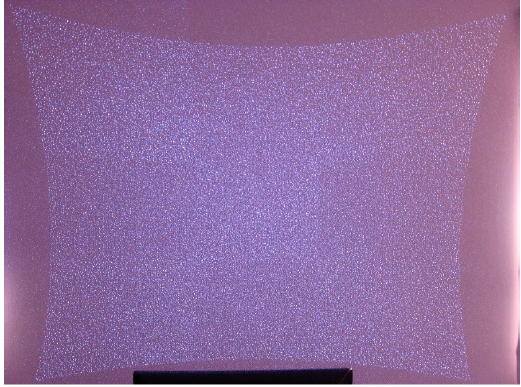
Figure 10. Projected pattern in Light coding.